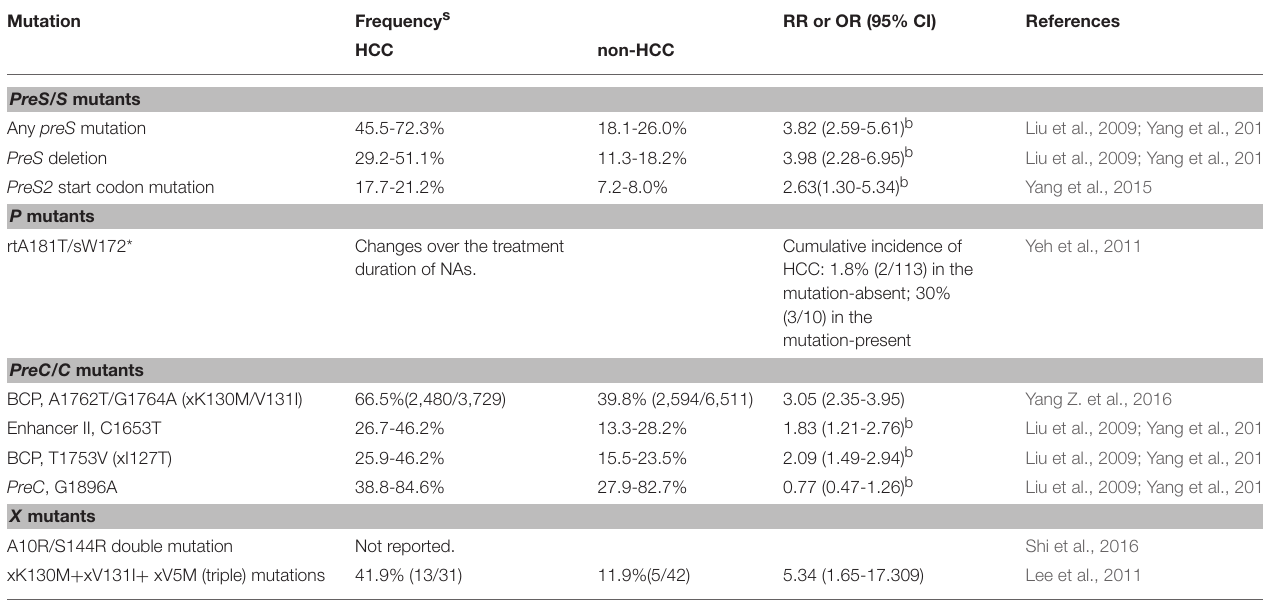
TABLE 1 | The association of HBV mutants with HCC